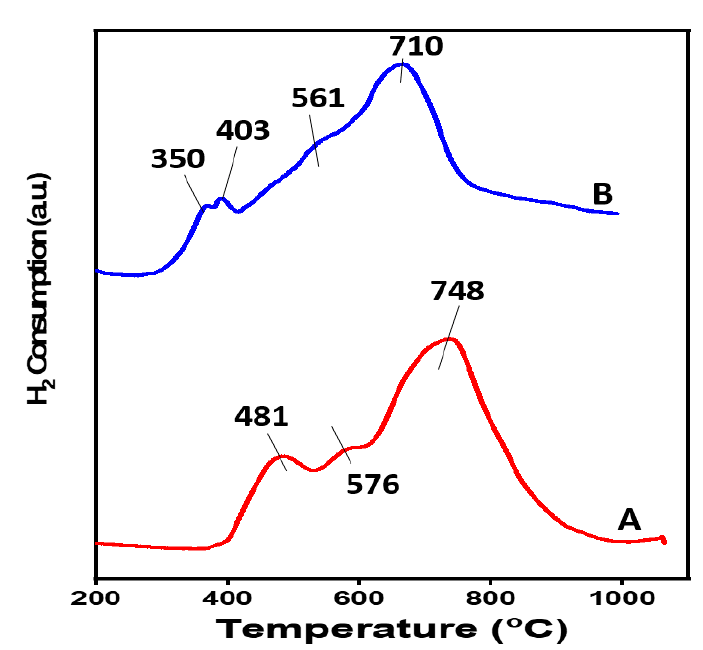
Figure 3. Temperature-programmed reduction (TPR) profile of NiMo / CaTiO 3 catalysts containing different CaTiO 3 support contents; (A) NMC412 and (B) NMC414.